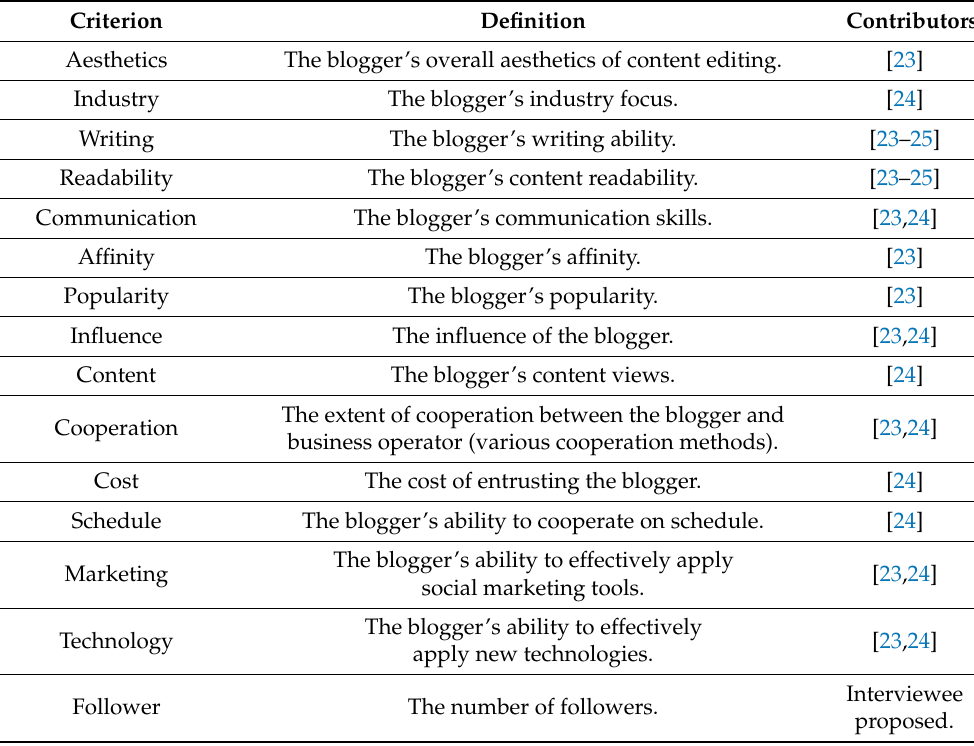
Table 2. The definitions and contributors of